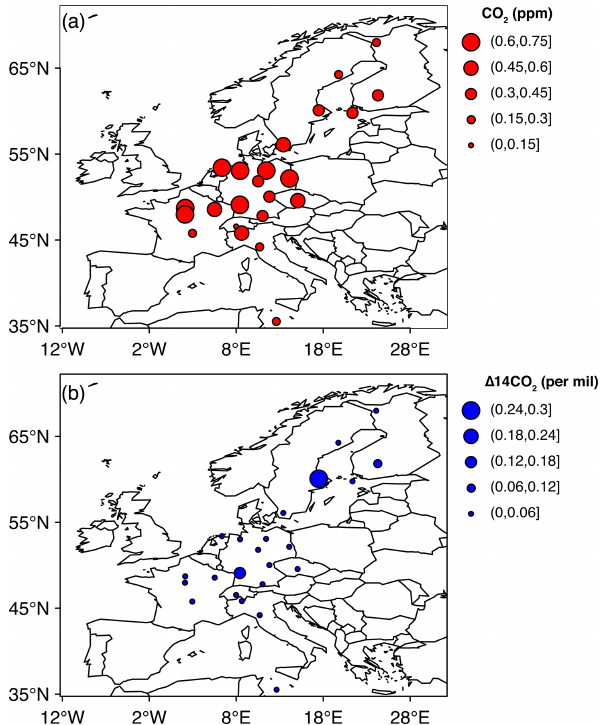
Figure 3. Maps showing the uncertainty at each site from the pro- jection of flux uncertainty into the observation space, (a) CO 2 mix- ing ratios and (b) (cid:49) 14 CO 2 .